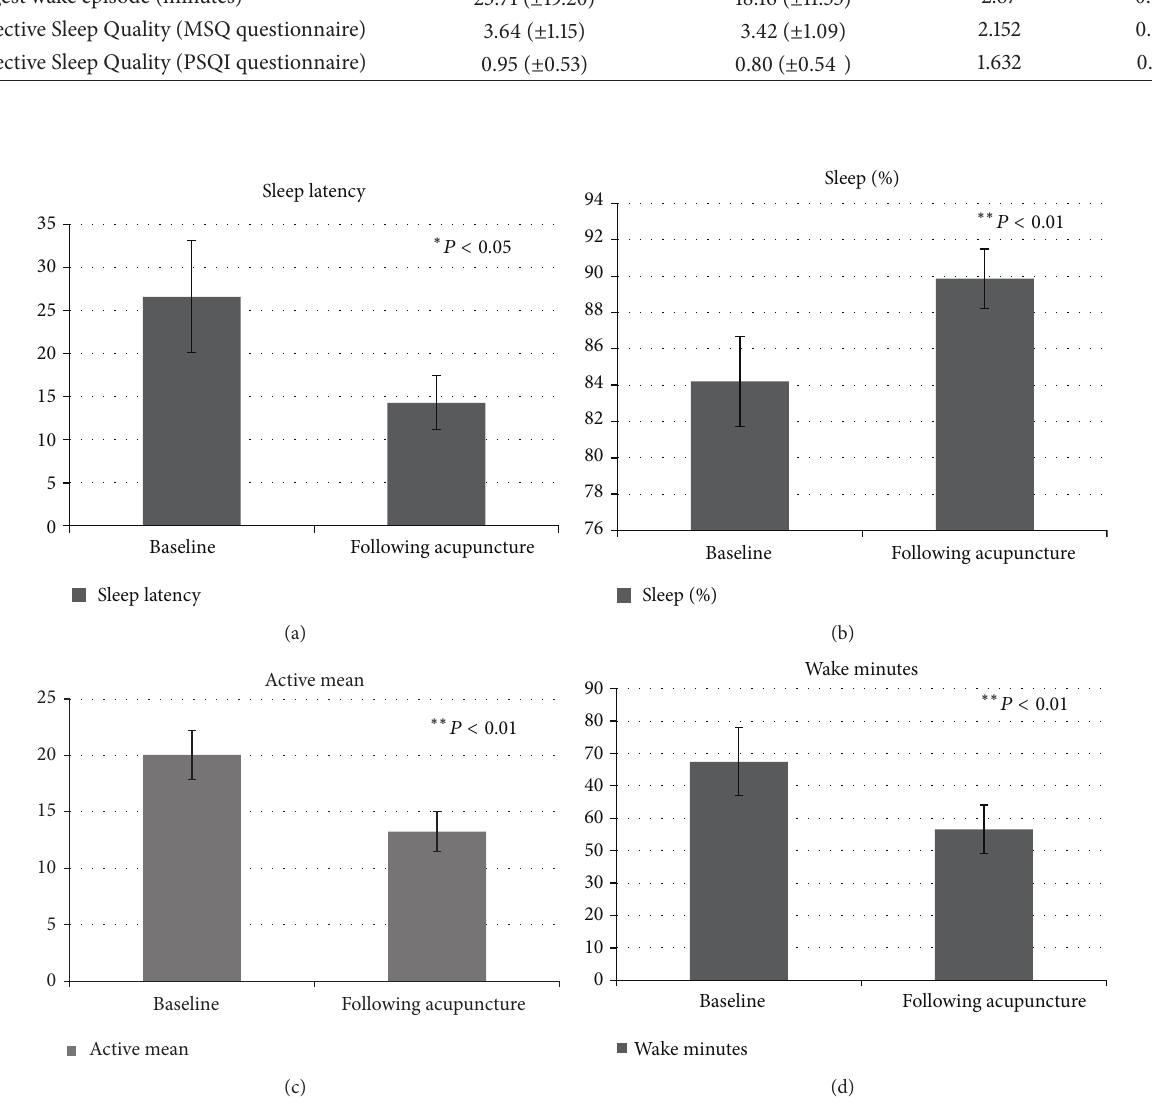
Figure 1: Objective measures of sleep as recorded by actigraph before and after acupuncture treatment: (a) sleep latency, (b) % of sleep percentage, (c) mean activity during sleep, and (d) total wake minutes during